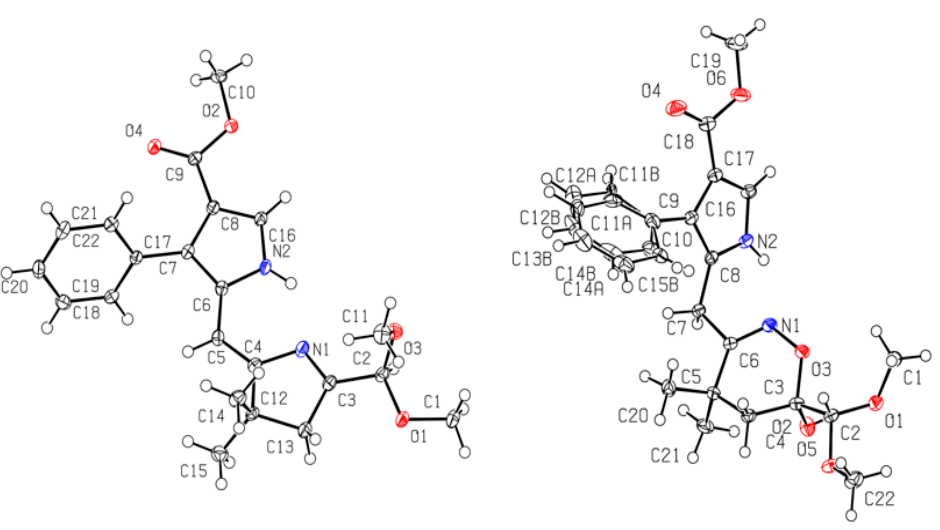
Figure 2. ORTEP diagrams of dihydrodipyrrin 5a ( left ) and pyrrole–dihydrooxazine 5b ( right ) (50% probability at 100 K).